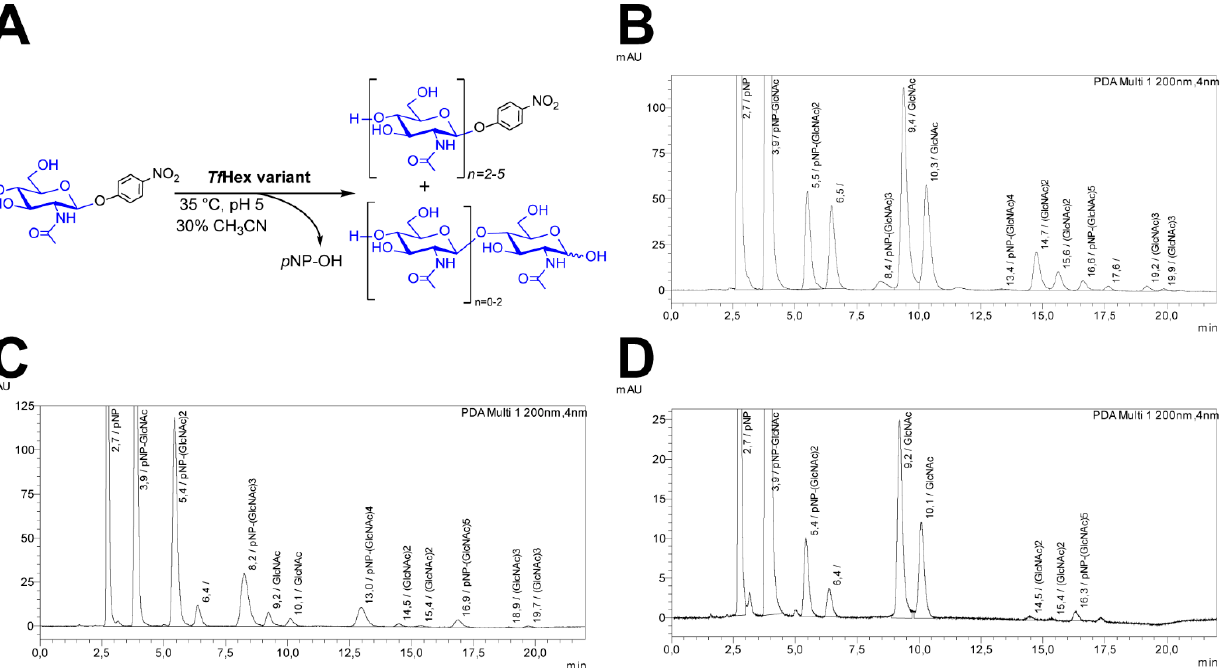
Figure 3. ( A ) Enzymatic synthesis of functionalized chitooligomers catalyzed by Tf Hex variants. ( B – D ) Comparison of formation of p NP-chitooligomers under the catalysis by ( B ) Tf Hex WT [32], ( C ) transglycosylating variant Glu332Gly Tf Hex, or ( D ) hydrolyzing variant Glu332Lys Tf Hex, using p NP-GlcNAc both as a donor and an acceptor in the same starting concentration and the same concentration of enzyme (U/mL) for all reactions. The reaction was analyzed after 5 h. The analysis was performed on a TSK gel Amide-80 column (for details see Section 4). For reducing carbohydrates, two peaks are visible due to the separation of α - and β